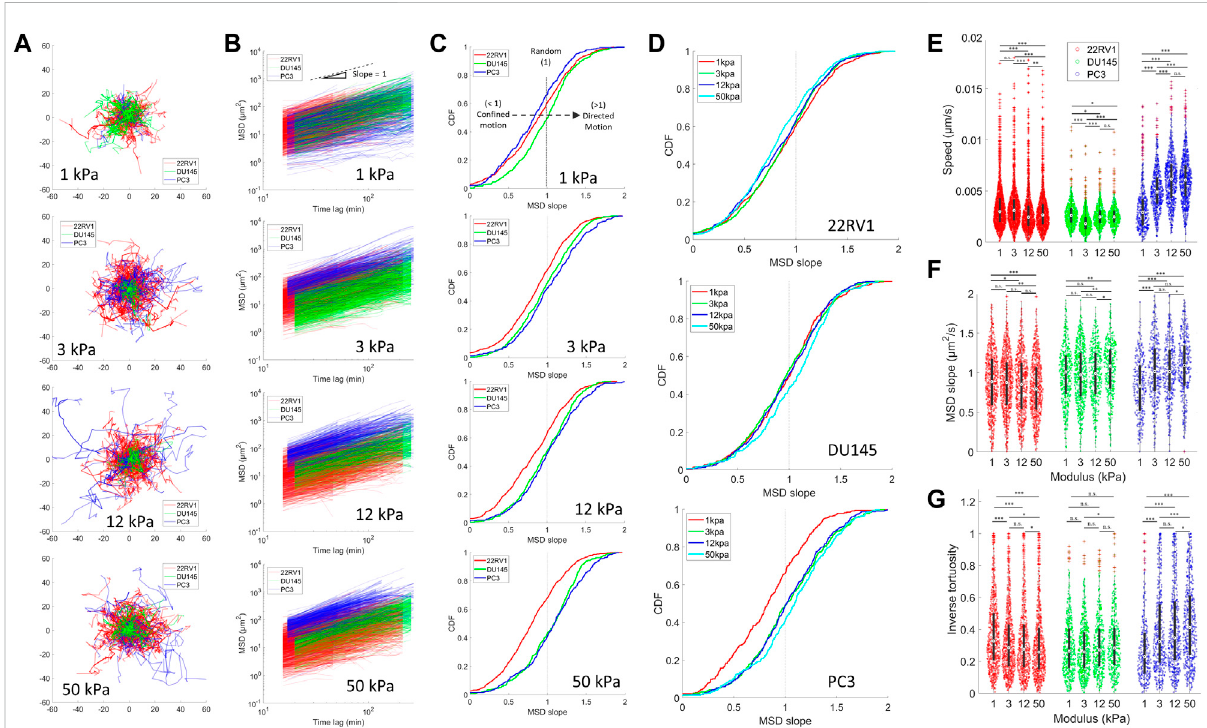
FIGURE 3 Motility is differentially affected by substrate stiffness for PCa monolayers of varying metastatic potential. Cell motility within a monolayer was measured for PCa cell lines plated on different substrate stiffnesses by tracking fl uorescently labelled nuclei. (A) Trajectories of PCa cell nuclei on different stiffnesses. (B) Mean squared displacements (MSD) as a function of time lag. The black dotted line indicates an MSD slope of one. (C) Cumulative probability density functions (CDF) of MSD of slopes calculated from the MSD-time-lag curves for all cell lines on each stiffness (Top – down: 1, 3, 12, and 50 kPa). MSD slopes indicate the nature of cell motion, where slope > 1 indicates directed motion, ~1 indicates random motion, < 1indicatescagedorconstrainedmotion,and0indicatesnomotion.RightwardshiftingoftheCDFcurvespastavalueof1indicatesalarger proportion of cells undergoing directed motion, as indicated by the black dashed arrow in the top panel. (D) CDF with the same data as shown in (C) but grouped according to cell type to display stiffness-dependent changes. (E) Average cell speed, (F) MSD slopes, and (G) inverse tortuosity of cells platedonvarioussubstratestiffnessasdeterminedbytrackingcellnuclei.Inversetortuosityindicatesthepersistenceofagivencelltrajectory,where 1 indicates a completely straight trajectory, and approaching zero is an in fi nitely curved trajectory. We were unable to establish an H2B-mTurq expressing cell line model inLNCaP, and thus theyare not included inthese fi gures. Statistics werecalculated usinga pairwise Mann – Whitney U test where * p < 0.1;** p < 0.01;*** p < 0.001.Pairwisestatisticalcomparisons acrossallgroups foraveragespeed, MSDslopes, and inversetortuosity may be found in Supplementary Tables S6, S7, and S8,